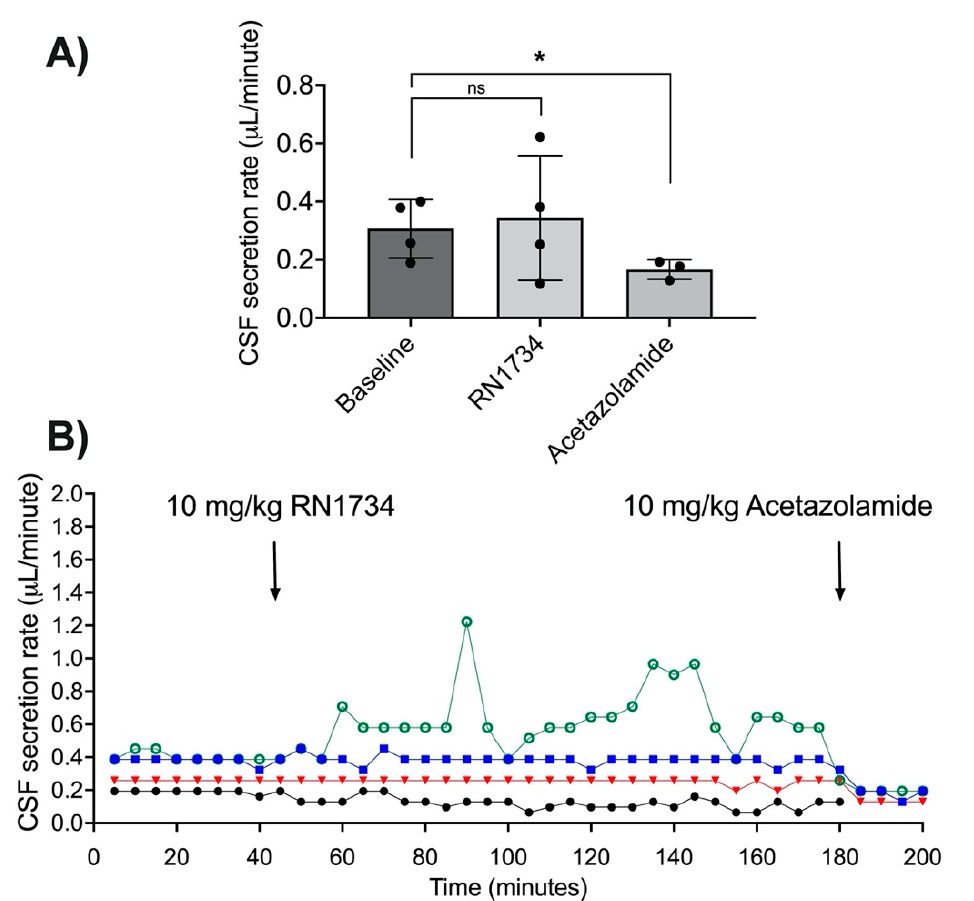
Figure 3. Effects of RN1734 on cerebrospinal fluid (CSF) secretion. ( A ) CSF secretion rate (mean ± SD; µ L/min) for all animals at baseline, after administration of RN1734, and after administration of acetazolamide. Points represent individual animals. ( B ) Individual CSF secretion rate plots over time in response to RN1734 and acetazolamide. Symbols and colours are distinct for each animal. ns, not significantly different, * p ≤ 0.05, Student’s t -test compared with baseline.